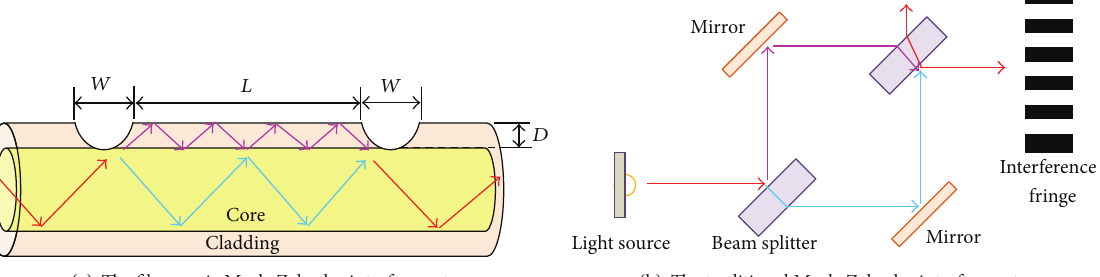
Figure 1: Optical transmission path.